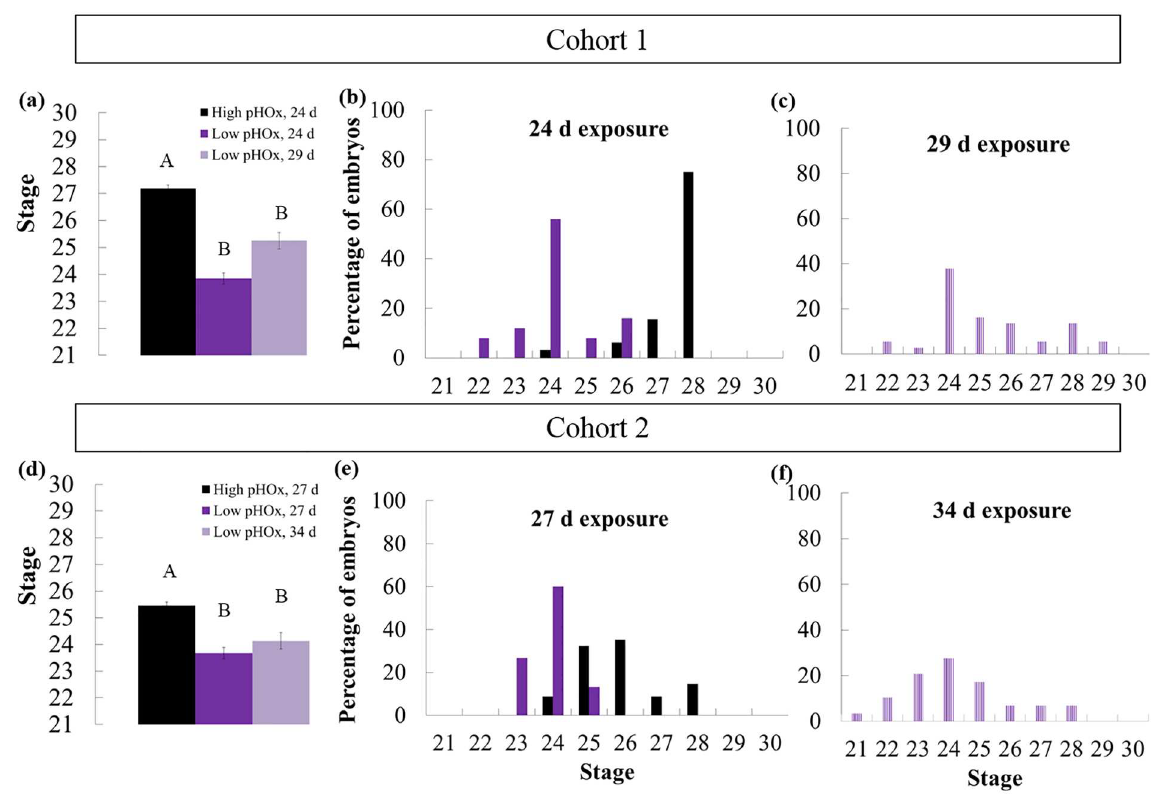
Fig 5. Experiment 1: Developmental categories of embryos across treatments and exposure duration. Black = Embryos from the High pHOx treatment, “standard”exposureduration, Dark Gray/Purple = Embryos from the Low pHOx treatment, “standard” exposureduration, Light Gray/Purple = Embryos from the Low pHOx treatment, “long” exposureduration. (a) Developmental categories of embryos from Cohort 1. Embryos were removedafter 24 d (both treatments) and 29 d of exposure (low pHOx only). Treatments were significantly different (Kruskal-Wallis χ 2 = 36.6724, DF = 2, p < 0 . 0001 )and letters indicate significantdifference amonggroups (Dunn pair-wisejoint rankingtest, p < 0 . 0001 ).Bar = ± 1 standarderror. (b) Histogramof embryos exposedfor 24 d to either high pHOx or low pHOx. (c) Histogram of embryos exposedfor 29 d to low pHOx. (d) Developmental categories of embryos from Cohort 2. Embryos were removedat 27 d (both treatments) and 34 d (low pHOx only). Treatments were significantly different (Kruskal-Wallis χ 2 = 28.0619, DF = 2, p < 0 . 0001 )and letters indicatesignificantdifference among groups (Dunn pair-wisejoint rankingtest, p < 0 . 0001 ).Bar = ± 1 standarderror. (e) Histogramof embryos exposedfor 27 d to either high pHOx or low pHOx. (f) Histogramof embryos exposedfor 34 d to low